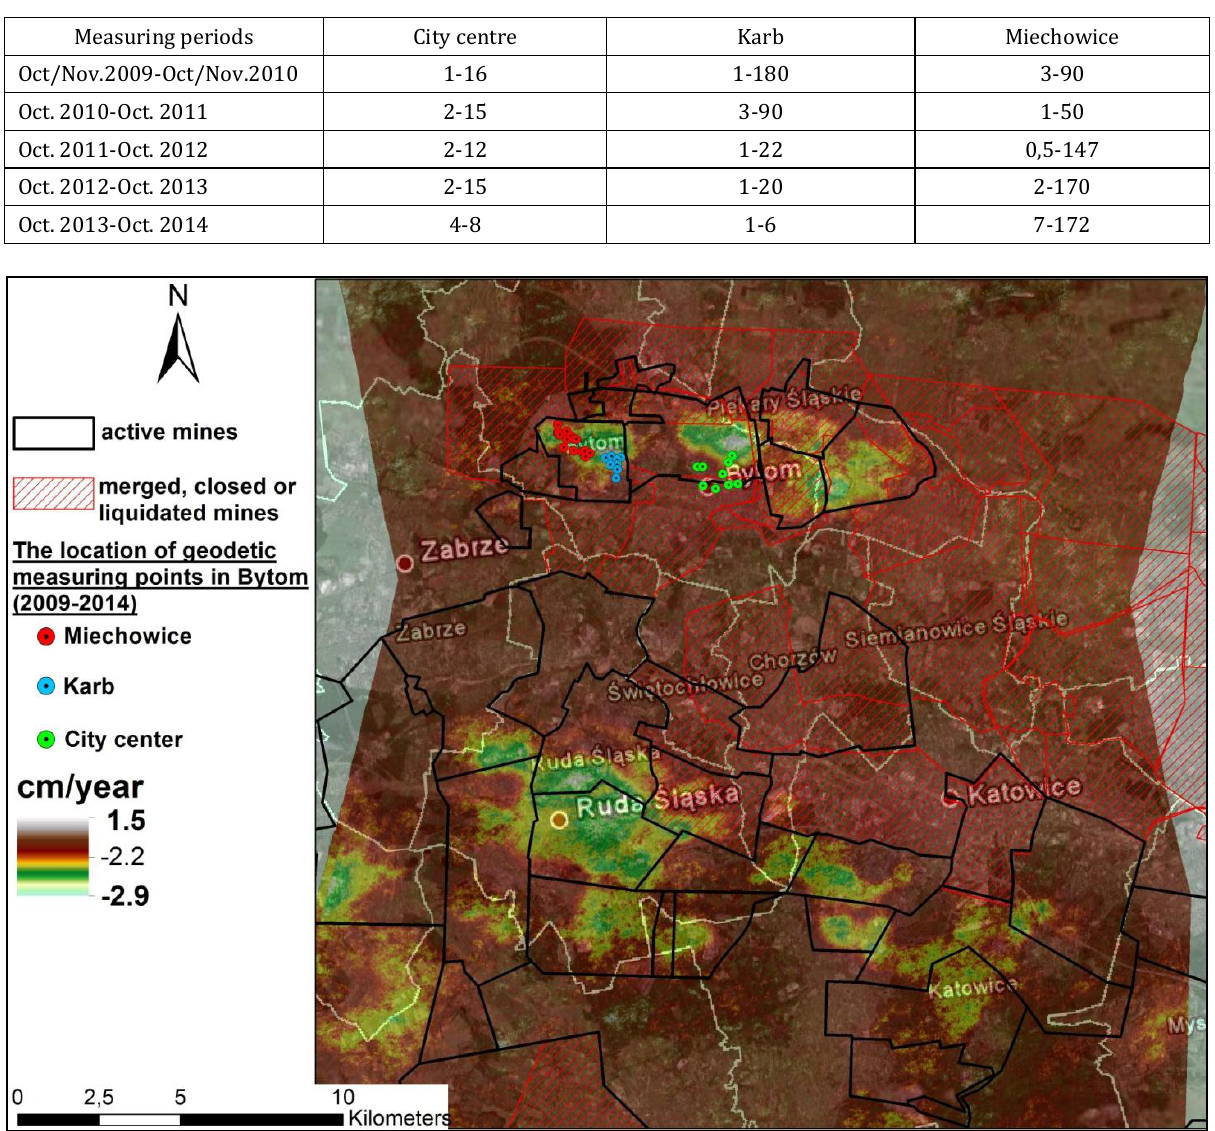
Fig.8. Mining caused subsidence from 08.05.2003– 5.08.2010 on Envisat ASAR layer stack, created with ascending- descending images from different paths. The values are representative; the map mostly serves only to introduce the most subsided areas together with the extension of active and inactive coal mines. The source of coal mining areas: http://dm.pgi.gov.pl/dm/DownloadManager_v1.aspx?lang=en, the data shows the status of mines in